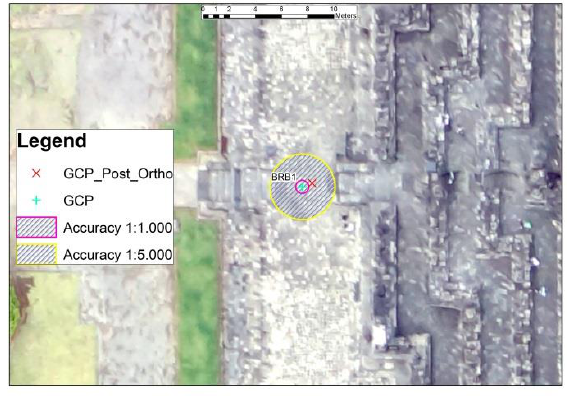
Figure 13. Planimetric Accuracy